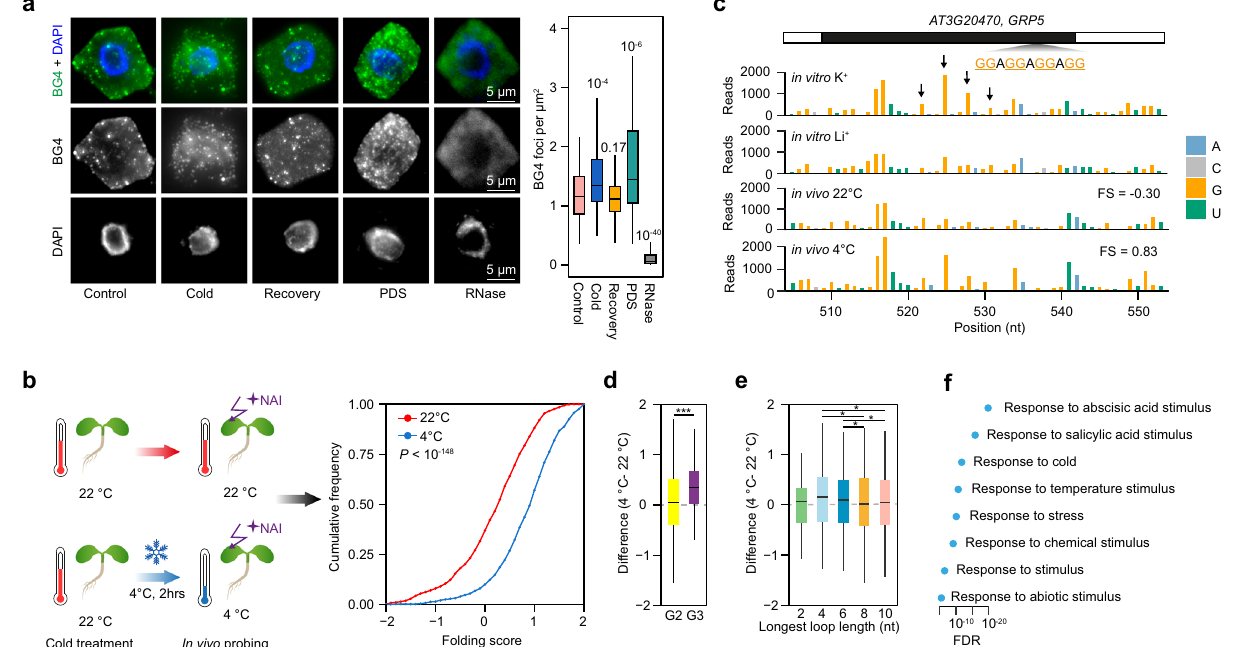
Fig. 2 | Cold promotes RNA G-quadruplex folding in Arabidopsis . a Immuno fl uorescence detection of G-quadruplex (RG4) with BG4 antibody in Arabidopsis under different thermal conditions. Arabidopsis seedlings were grown at22°C(Control)andwere(i)treatedat4°Cfor2h(Cold);or(ii)returnedto22°C for 2h after cold treatment (Recovery); or (iii) treated with 10 μ M pyridostatin (PDS);or(iv)treatedwithRNasecocktail(RNase).DAPIindicatesthenucleussignal. Statistical analysis was performed using >80 cells from three individual seedlings for each treatment, with signi fi cance tested by Student ’ s t test in comparison to Control. b ComparisonofRG4foldingbySHALiPE-seqinplantsgrownat22°Cand treated either at 4°C or 22°C, respectively, n =817, P <10 − 148 , by one-sided Stu-